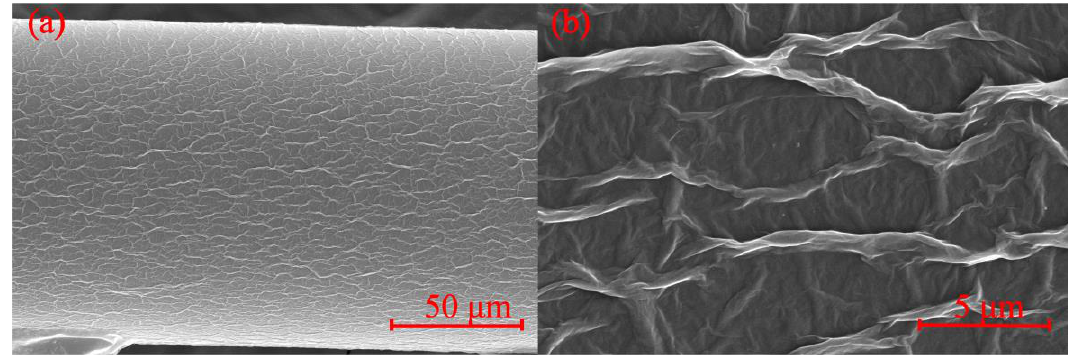
Figure 4. Schematic of coating graphene oxide onto the fiber.